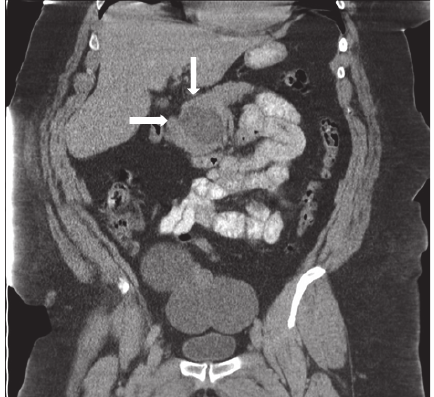
Figure 2: MRI of a patient with autoimmune pancreatitis in coronal orientation showing a tumor in the pancreatic head (focal type; white